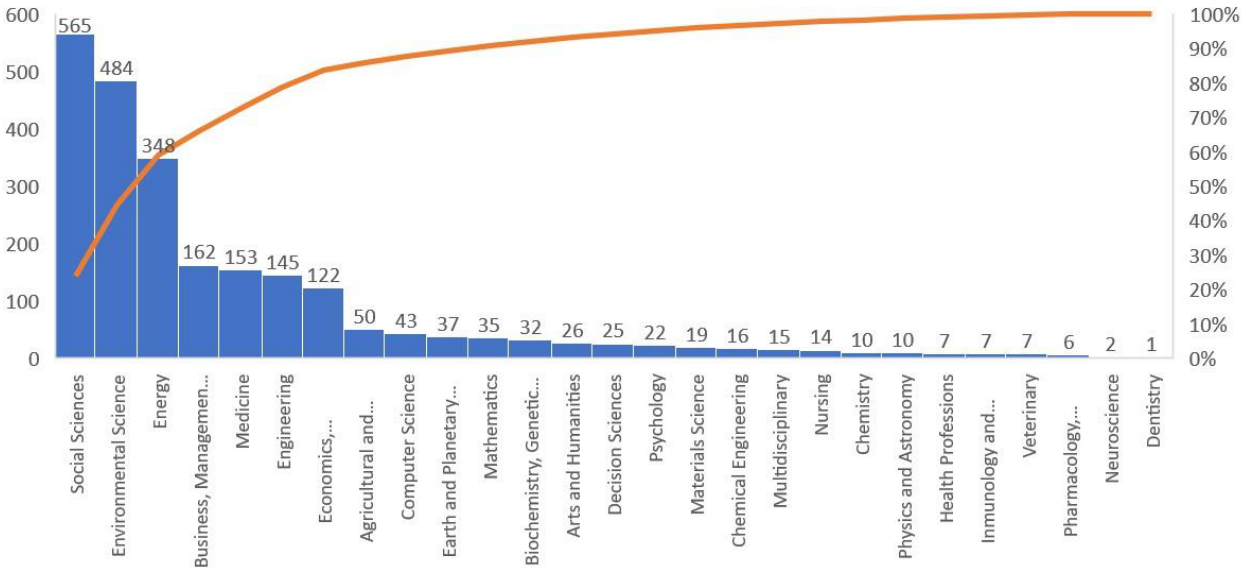
Table 3. The 10 most cited articles.